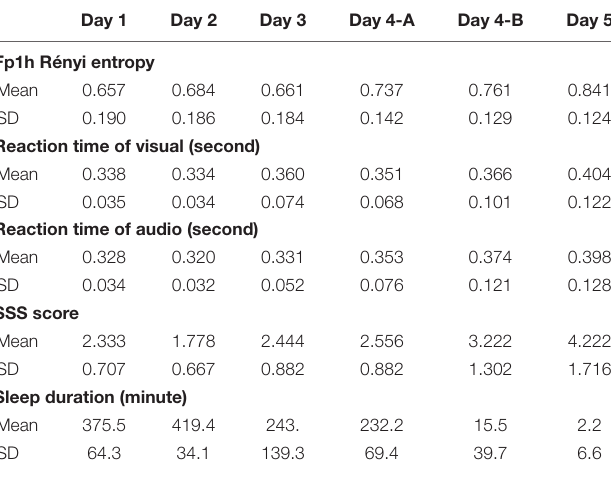
TABLE 1 | Descriptive statistics of Rényi entropy, oddball reaction time, SSS score, and sleep duration across six